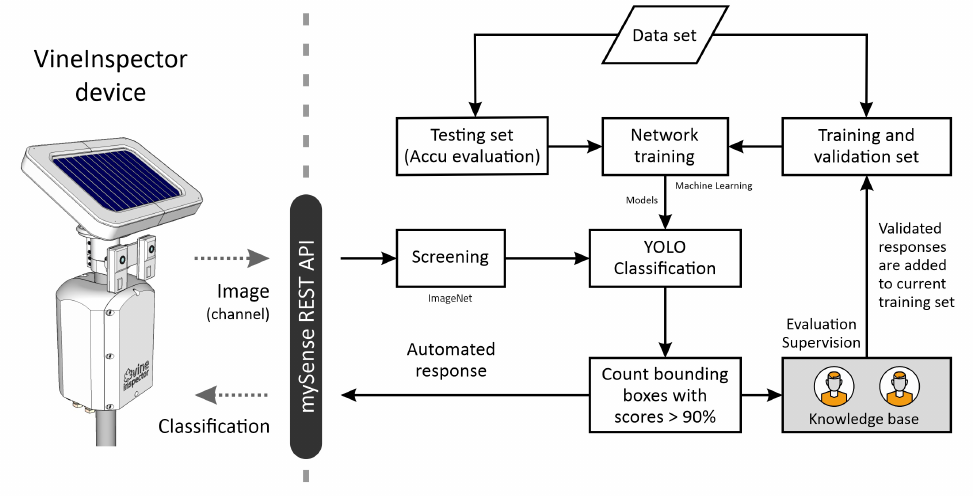
Figure 4. Remote cloud-based platform software